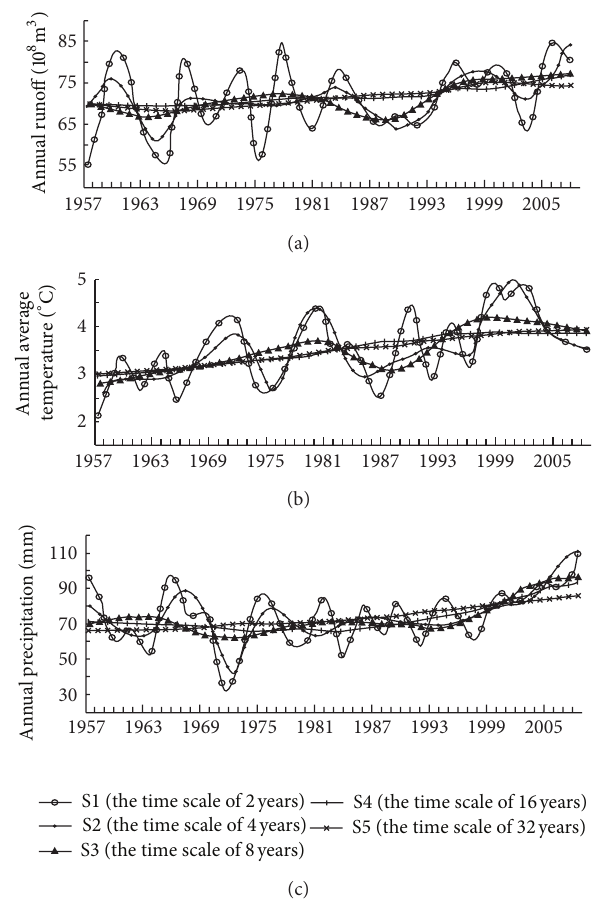
Figure 2: Variation patterns at different time scales of (a) annual runoff,(b)annualaveragetemperature,and(c)annualprecipitation.